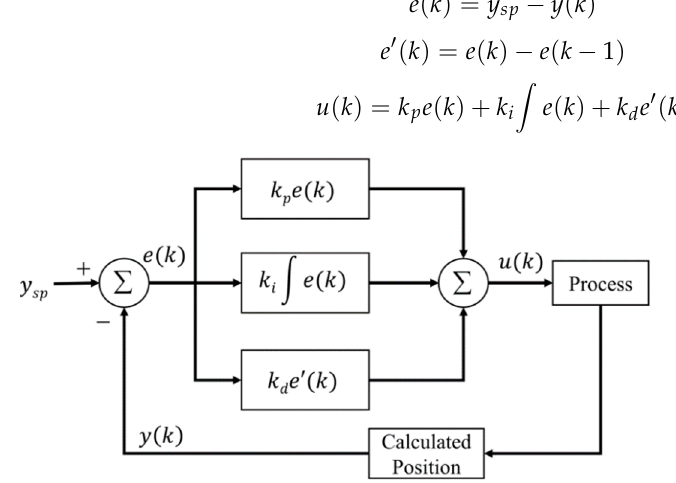
Figure 1. Architecture diagram of conventional PID control in robot